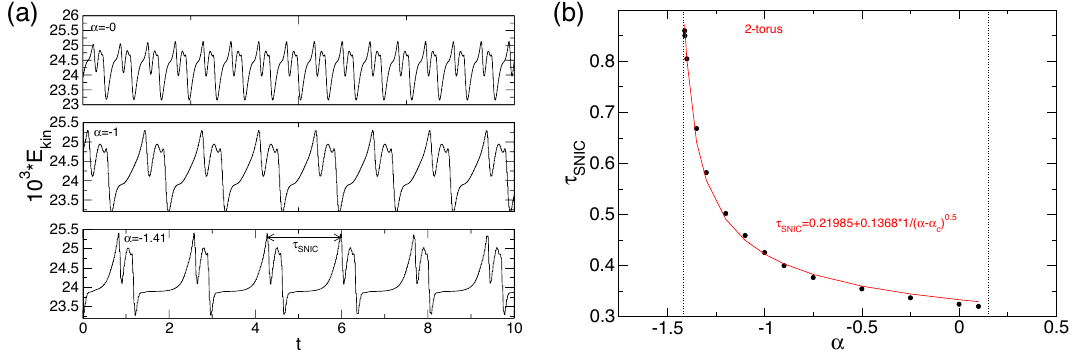
Figure 15. Saddle node on an invariant circle bifurcation for pV 1 . ( a ) Time series of E kin for pV 1 at α as indicated; ( b ) Variation of τ SNIC with α for pV 1 (see Fig. 14). The solid circles are the computed periods, and α c . Note that in the region, 0.15 < α < 0.67 , no pV state, a 0 a i / √ α the line is a fit of the form, τ SNIC = + − whether stable nor unstable, can be detected, even in subspaces (see section “Unstable pV states”).